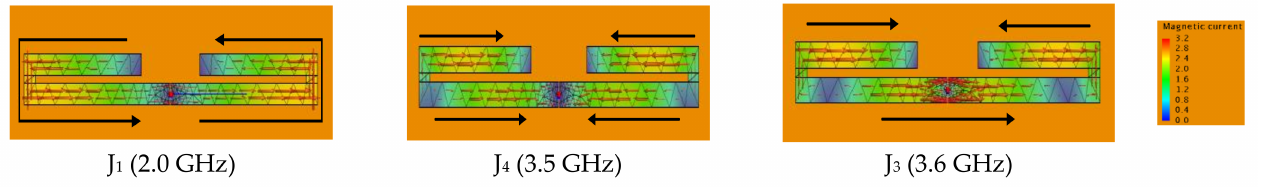
Figure 4. Characteristic magnetic currents of the folding-slot